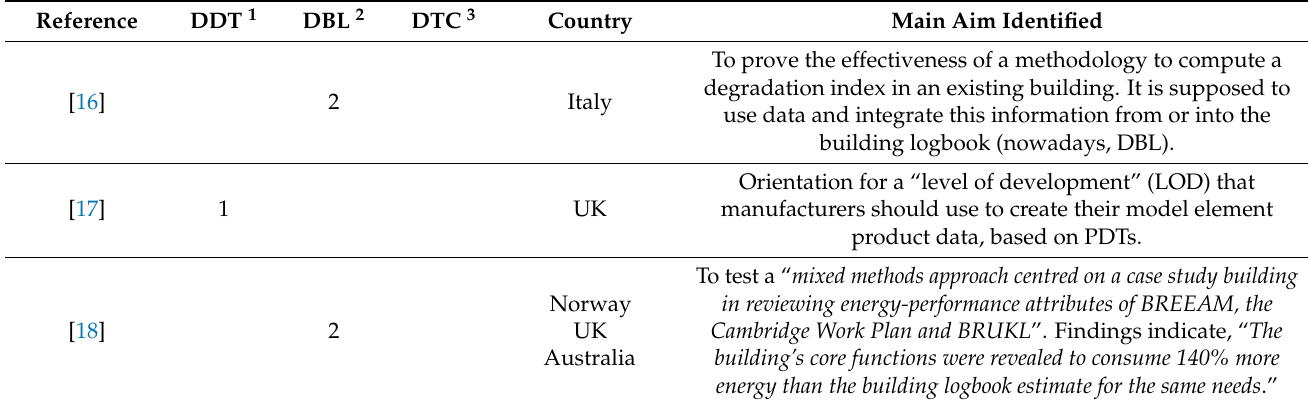
Figure 2. Network map of referenced keyword clusters and pie charts evidencing the years, countries, and origin in terms of journals or publication sources. Table 2. The content of the selected publications (Scopus and WOS), in terms of digital solutions implemented (the concepts are marked with numbers, 1 for DDT—digital data templates; 2 for DBL—digital building logbook and 3 for DTC—digital twin construction). As well, the main research aim is